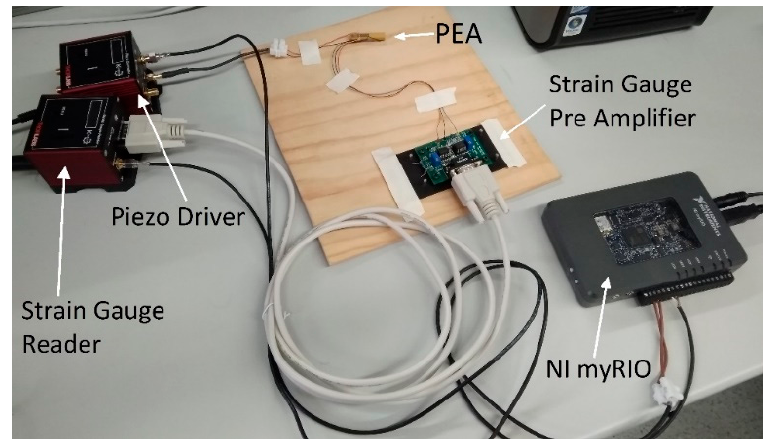
Figure 1. Experimental setup.